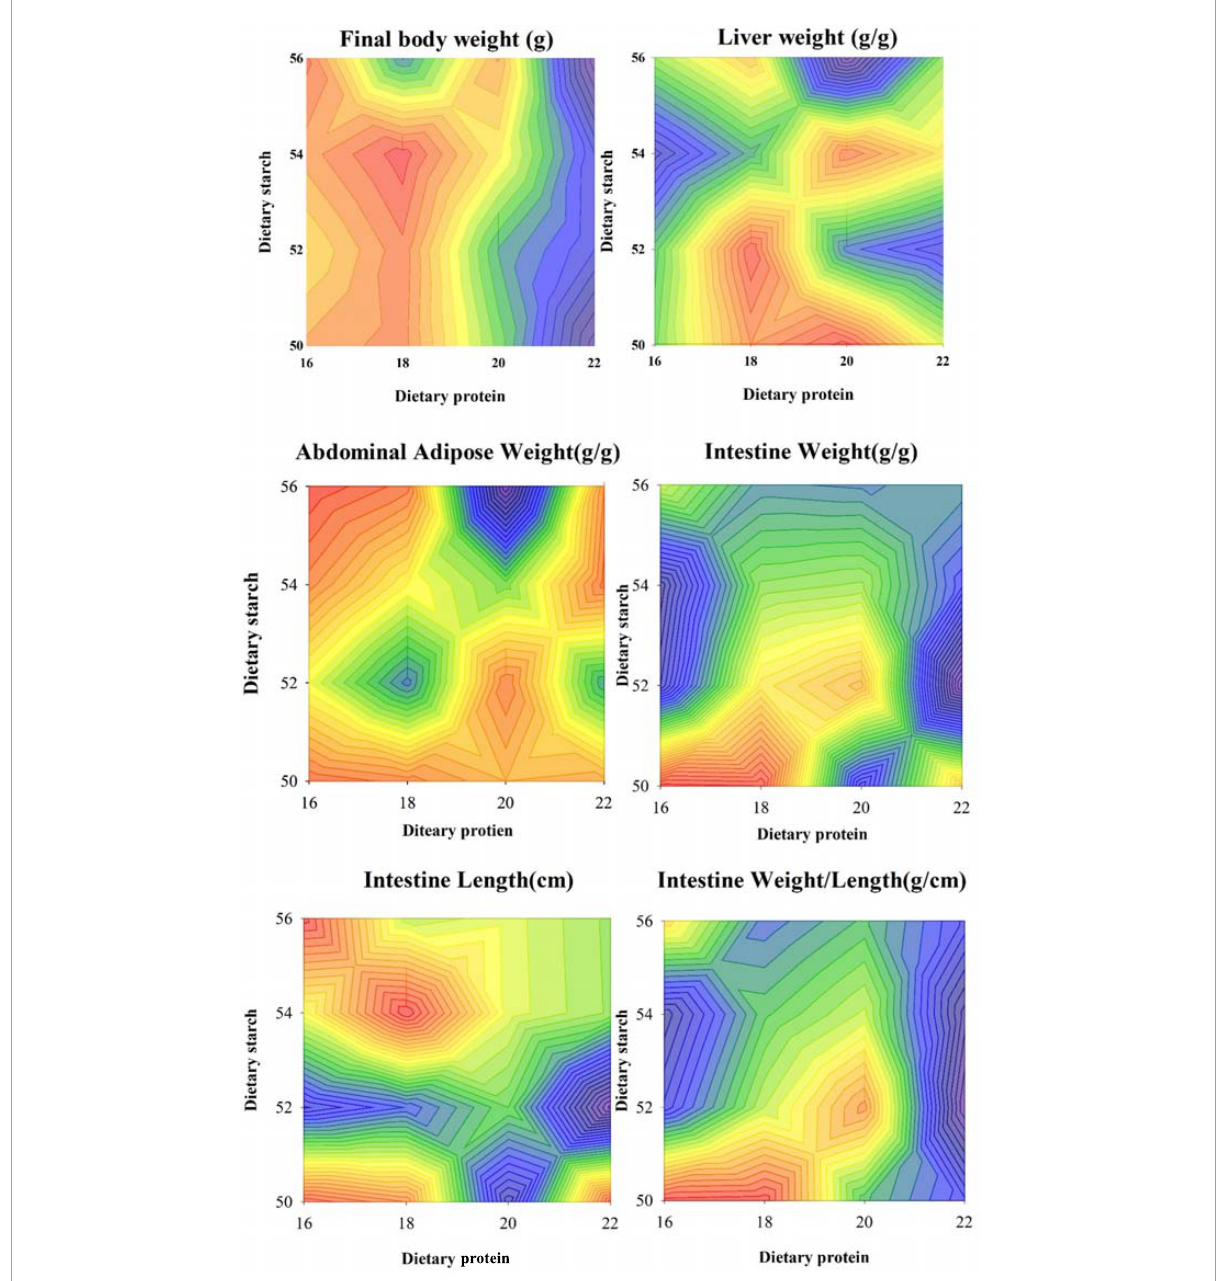
FIGURE1 Effects of different ratios of starch and protein in diet on final weight and organ index of mice. The value increases with the deepening of red and decreases with the deepening of blue.